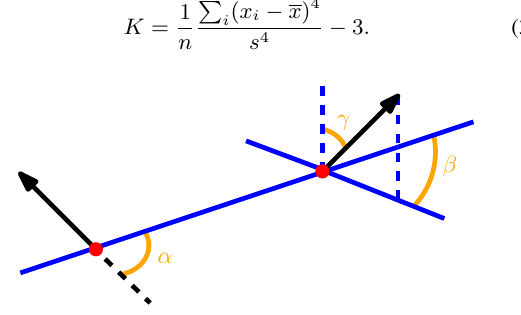
Figure 4. Considered angles between surflet